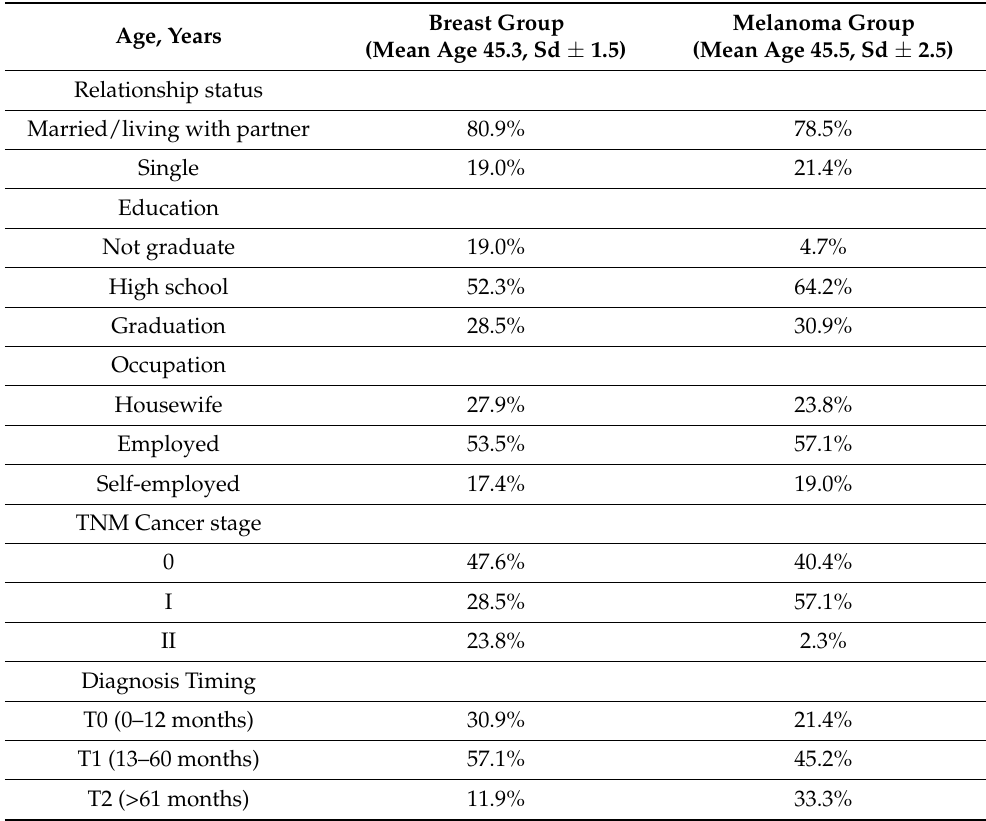
Table 1. Sociodemographic data of